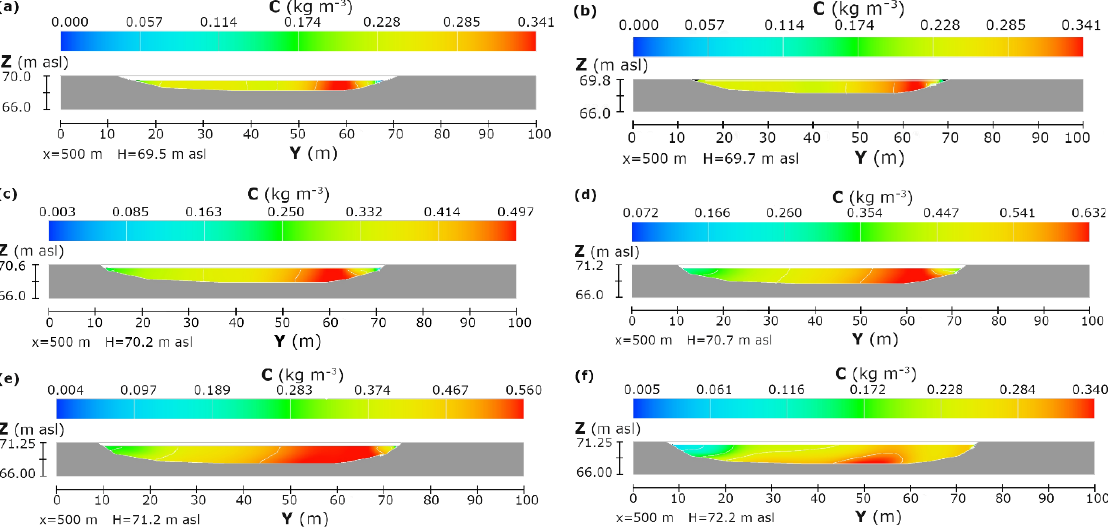
= 41 m 3 s -1 , (b) Q = 51 m 3 s -1 , (c) Q = 77.2 i i i